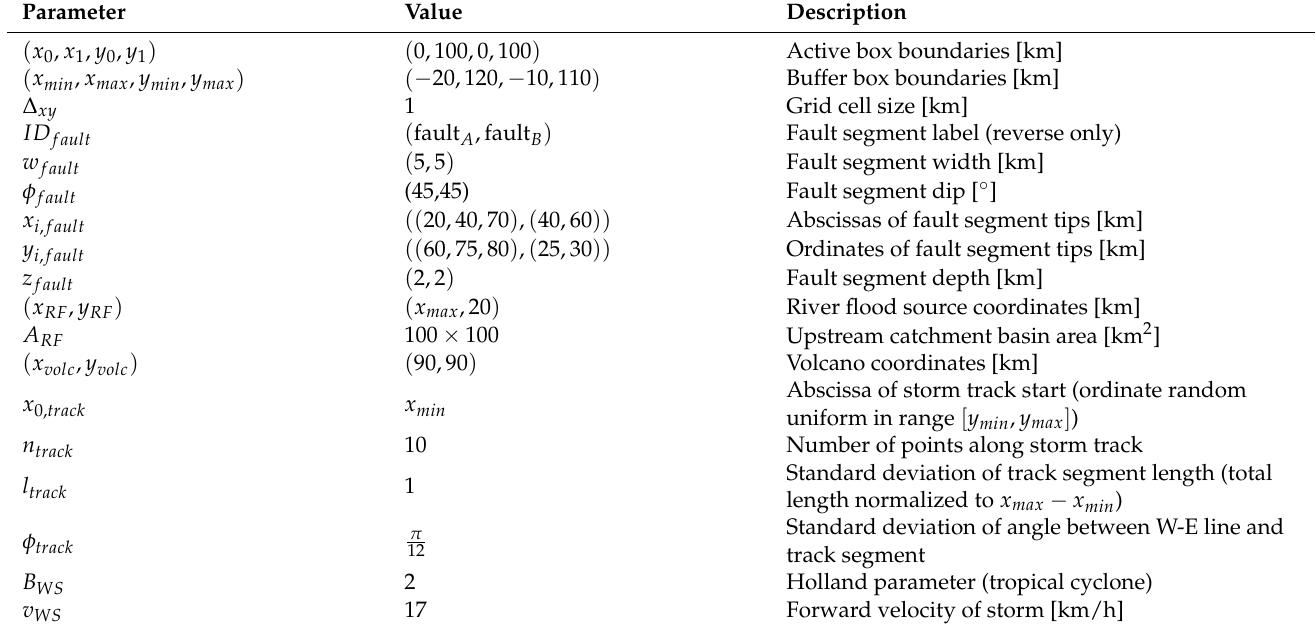
Table A2. Default parameterization for the spatial grid and peril source characteristics.